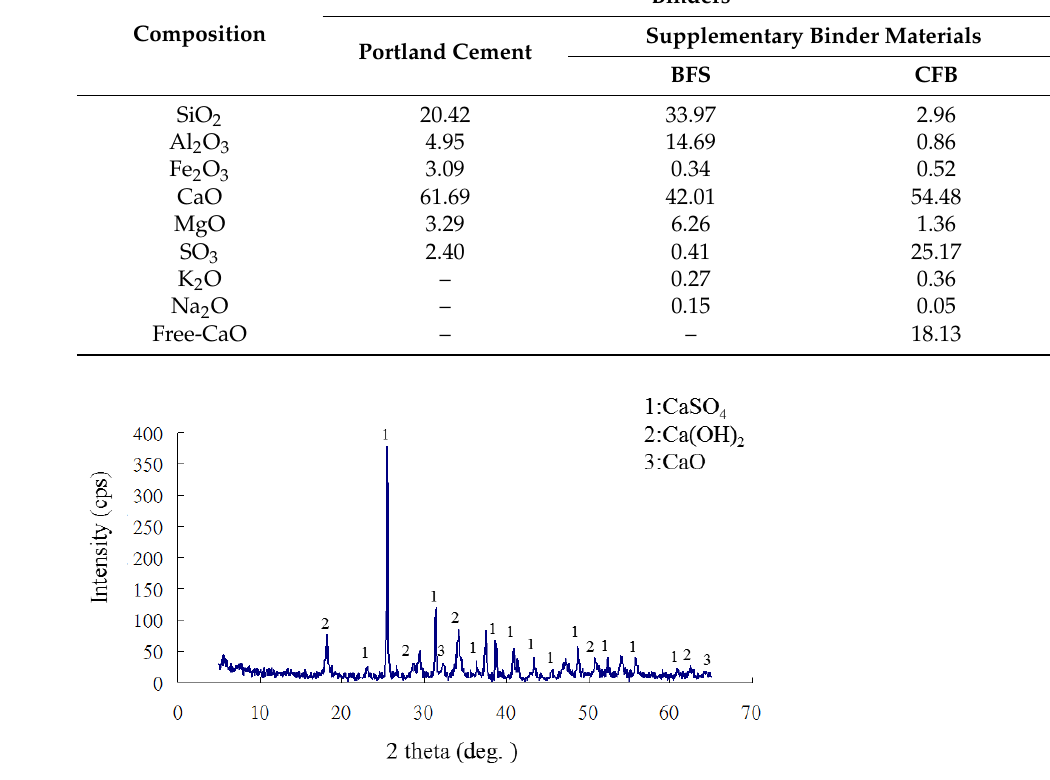
Figure 1. XRD pattern of CFB fly ash.